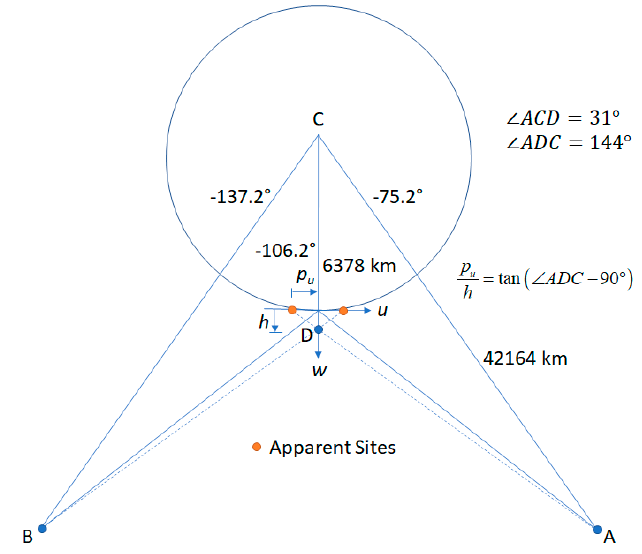
Figure 23. The geometry of stereo-winds retrieval with two GOES spacecraft is represented (not to scale) at a site bisecting the two satellites on the equator. The angle ∠ ACD is half the longitude separation between the spacecraft and ∠ ADC is found by the law of cosines. In the limit as h → 0, the ratio of the parallax to the height approaches tan ( ∠ ADC − 90 ◦ ) .